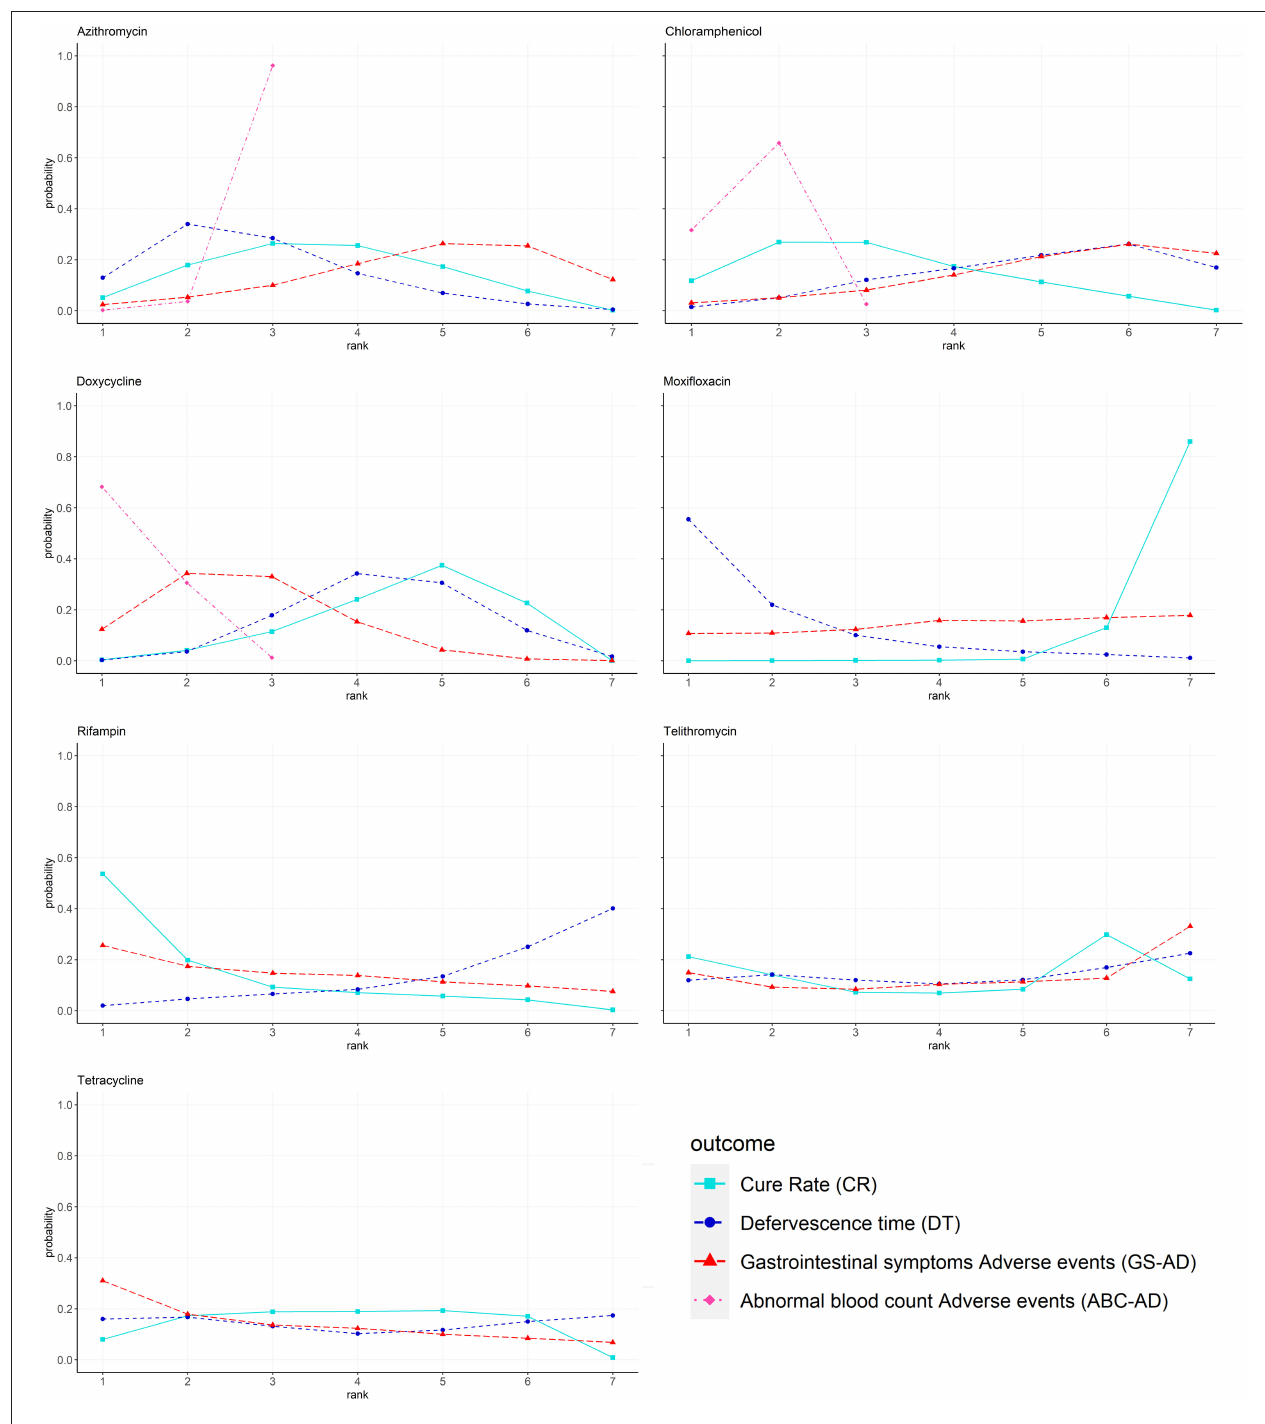
FIGURE 4 | Bayesian ranking profiles of comparable treatments on efficacy for patients with advanced scrub typhus. Profiles indicate the probability of each comparable treatment being ranked from first to last on CR DT GS-AD and ABC-AD. Ranking curves are described according to the Bayesian ranking results presented in Supplementary Material S8